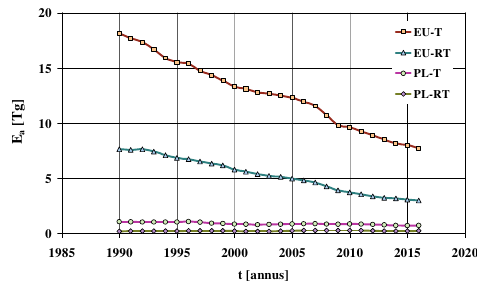
Fig. 3. Annual emission of nitrogen oxides: total in the European Union – EU-T, from motor vehicles in the European Union – EU-RT, total in Poland – PL-T, from motor vehicles in Poland – PL-RT in years 1990–2016